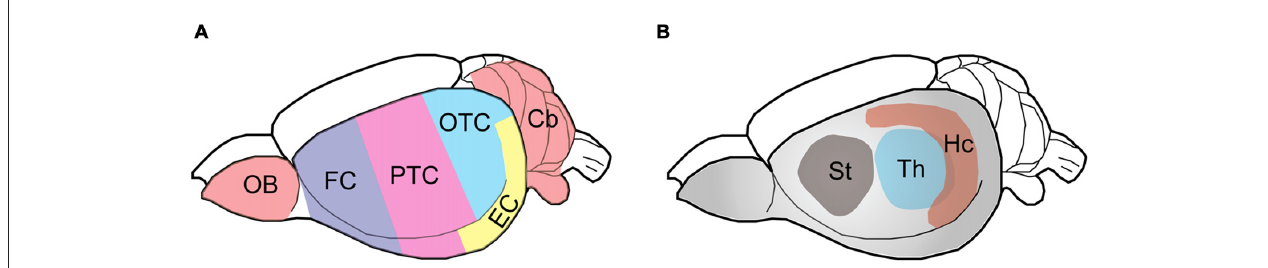
FIGURE 1 | Schematic diagram showing the rat brain regions examined. Color codes show the olfactory bulb (OB), cerebellum and cerebral cortical regions (A) and subcortical areas (B) studied. The rat brain was submerged in ice-cold PBS and subjected to dissection on a piece of wet filter paper on ice. The OB and the cerebellum (Cb) were first sampled, followed by the hippocampus (Hc), the thalamus (Th) and the striatum (St). The hypothalamus and the brain stem were discarded. After the entorhinal cortex (EC) was dissected, the remaining cerebral cortex tissue was coronally cut into three parts identically along the axial axis to represent the frontal cortex (FC), parietal-temporal cortex (PTC), and occipital-temporal cortex (OTC).